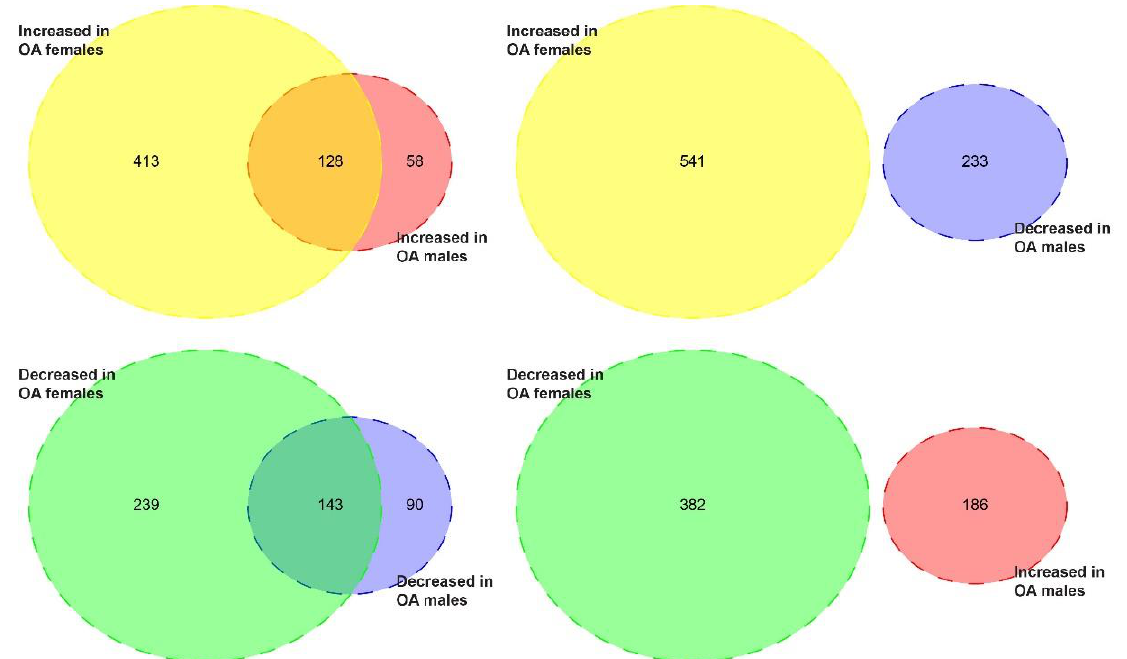
Figure 3. The Venn diagrams visualize the OA-responsive DEGs with the same or different expression trends in male and female cartilage samples. There are 541 increased and 382 decreased DEGs in female cartilage in response to OA, while there are 186 increased and 233 decreased DEGs in male cartilage in response to OA. When comparing DEGs in both genders, there are 128 upregulated DEGs and 143 downregulated DEGs shared by both genders. No gene exhibited different expression trends in males and females in response to